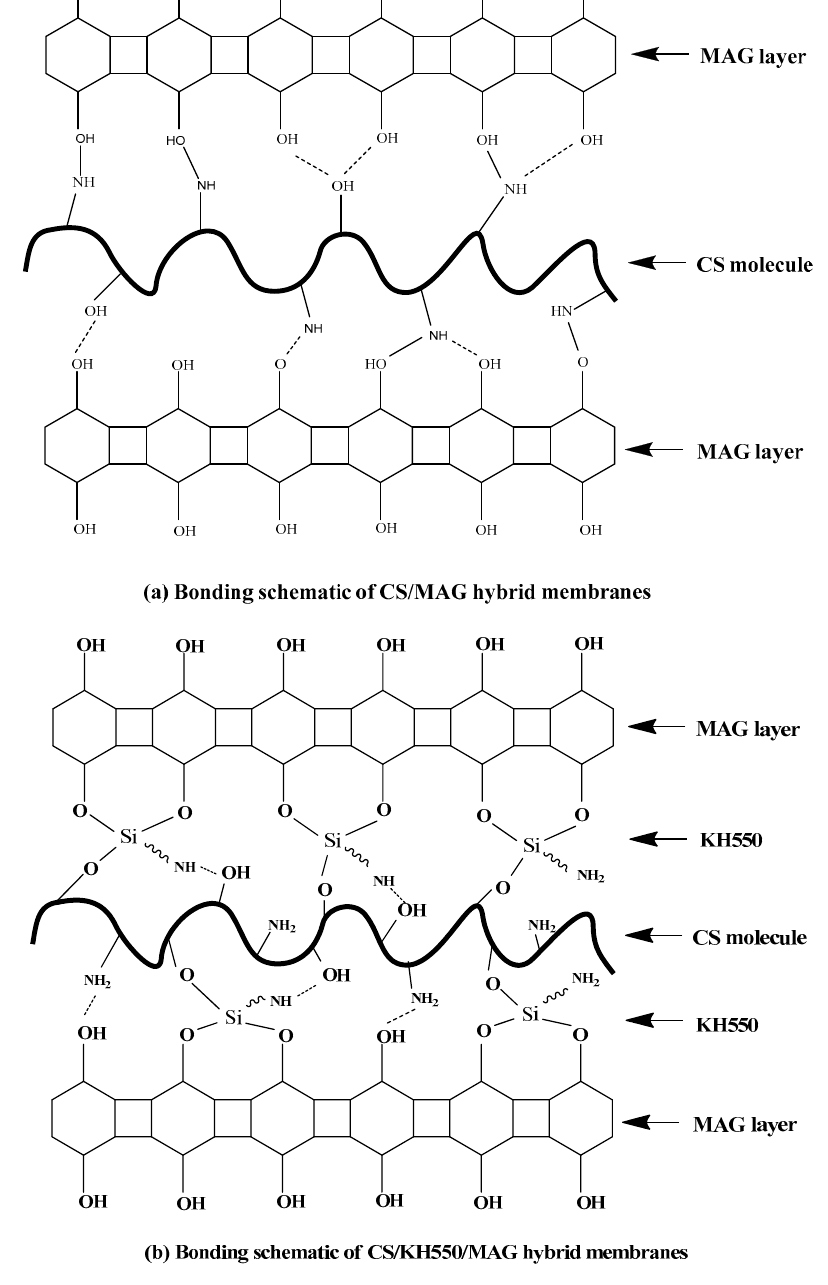
Figure 5. The bonding schematics of ( a ) CS/MAG and ( b ) CS/KH550/MAG hybrid membranes.